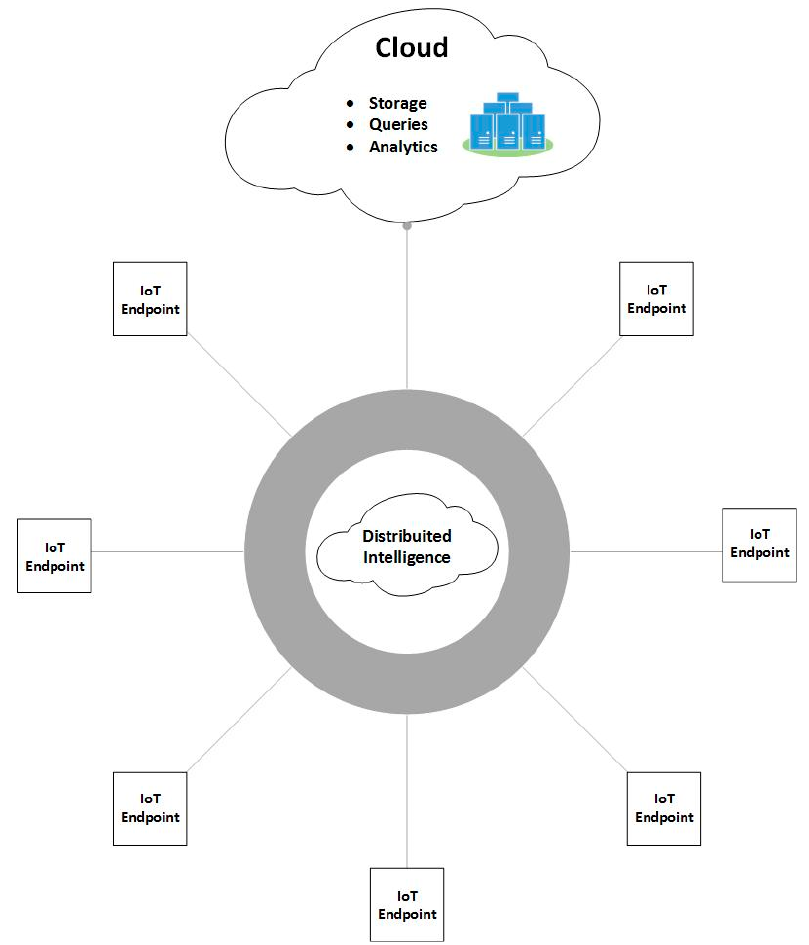
Figure 4. Edge Computing-based architecture.